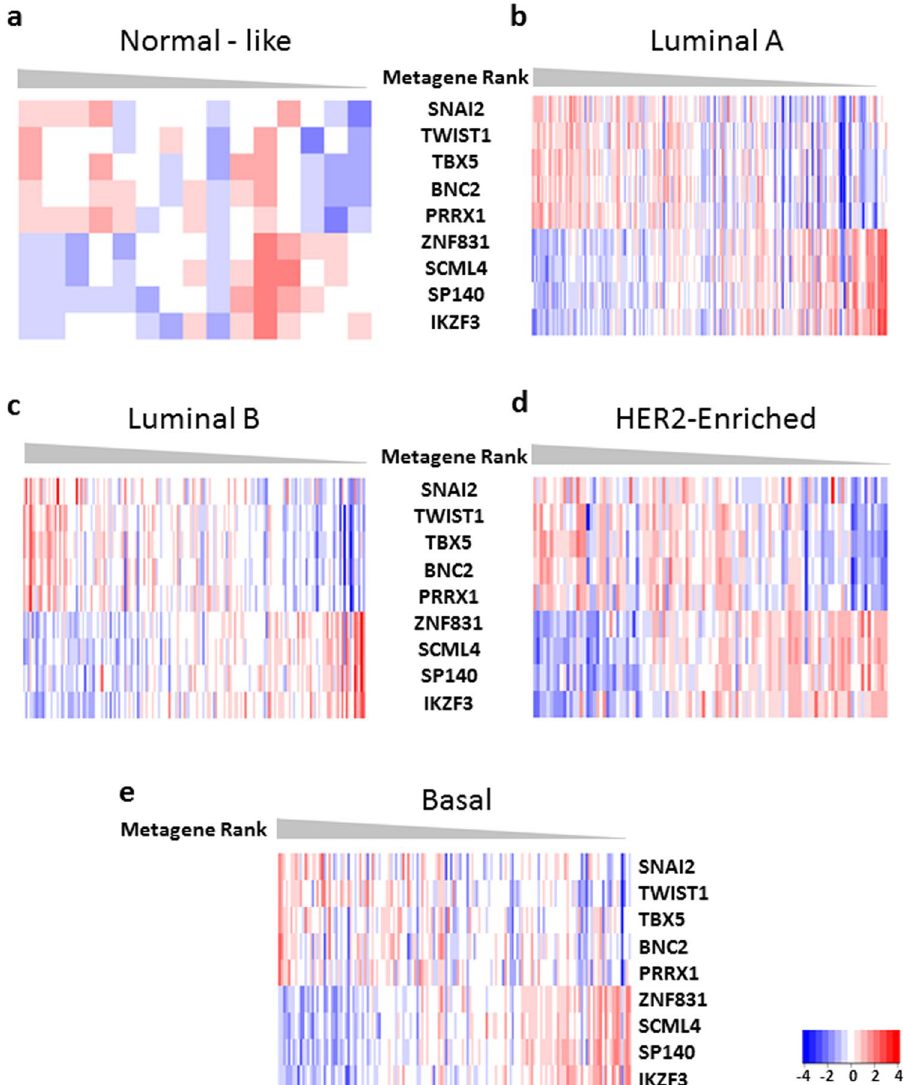
Figure 3. Coordinated expression of the TFs of the two modules is independent of the PAM50 classification in the TCGA-BRCA dataset - Coordinated expression of the TFs in the two validated networks. Heatmap of invasive ductal breast cancer tissue from females of the TCGA-BRCA dataset, ordered by the rank of the metagene of all TFs in the two validated networks. (a): 15 Normal-Like samples, ( b ): 189 Luminal A Samples, ( c ): 162 Luminal B Samples, ( d ): 107 Her2-enriched Samples, ( e ): 148 Basal Samples. Metagene Rank: Order of the samples as calculated by the expression of the